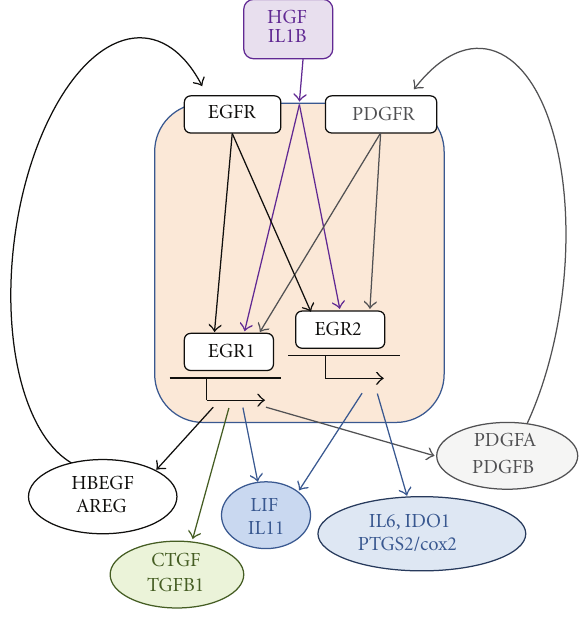
Figure 1: The roles of EGR1 and EGR2 signaling and autocrine loops with EGFR and PDGFR ligands in the production of select bioactive molecules in MSCs. (Abbreviations: CTGF, connective tissue growth factor; EGF, epidermal growth factor; EGFR, epi- dermal growth factor receptor; EGR, early growth response gene; HBEGF, heparin-binding epidermal growth factor-like growth factor; IDO1, indoleamine dioxygenase-1; IL1B, interleukin-1beta; IL6, interleukin-6; LIF, leukemia inhibitory factor; PDGFA, platelet- derived growth factor-A; PDGFB, platelet-derived growth factor- B; PTGS2/cox2, prostaglandin-endoperoxide synthase 2/cyclooxy- genase-2; TGFB1, transforming growth factor-beta1; VEGFA, vas- cular endothelial growth